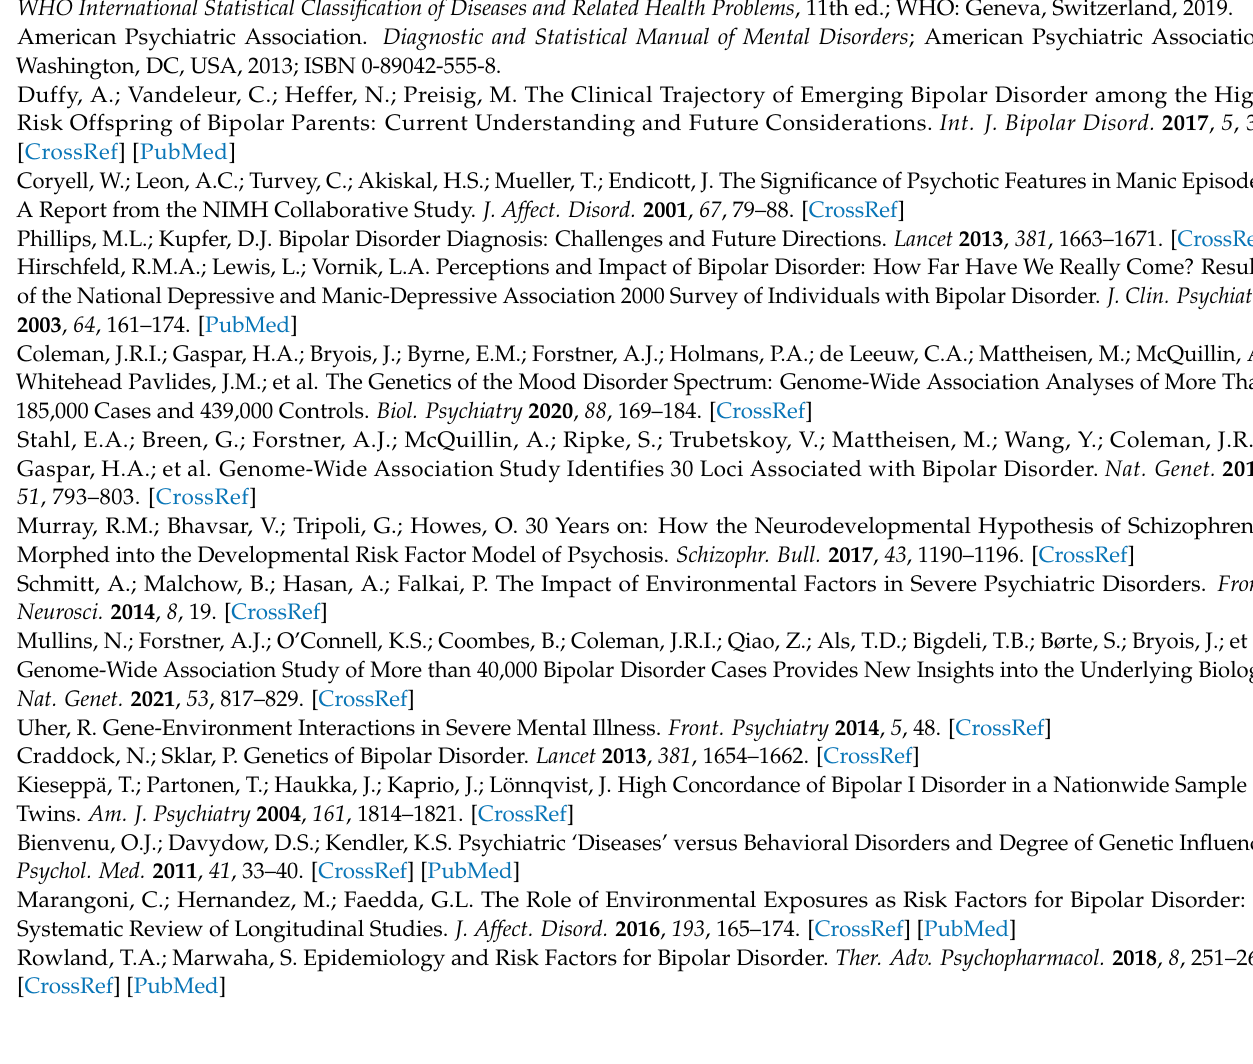
Figure S2: Flowchart outlining the protocol adopted in the search for eligible papers adressing exposome-associated changes in peripheral circulatory miRNAs in bipolar disorder; Figure S3: BD I regional association plots of selected miRNA loci; Figure S4: BD II regional association plots of selected miRNA loci; Table S1: miRNAs located in GWS loci in the largest BD GWAS